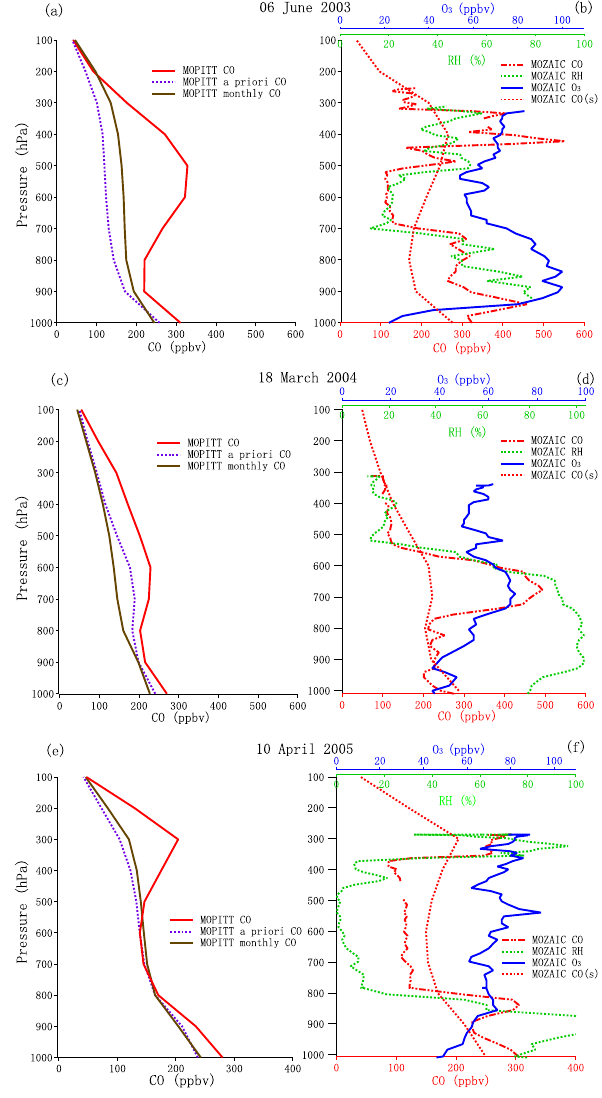
Figure 5. Profiles of MOPITT CO and the a priori, averaged over the corresponding boxed area in Fig. 4 on (a) 6 June 2003, (c) 18 March 2004, and (e) 10 April 2005, respectively, along with their monthly mean MOPITT CO profile over the same area. The cor- responding MOZAIC CO profiles (along the dots in Fig. 4) on the same day are shown in (b) , (d) , and (f) , respectively. The corre- sponding MOZAIC ozone and relative humidity profiles are also shown in (b) , (d) , and (f) . Note that the smoothed MOZAIC CO profiles (MOZAIC CO(s)) were calculated using the averaging ker- nels and the a priori in the boxed area in each case (see Sect. 5 for